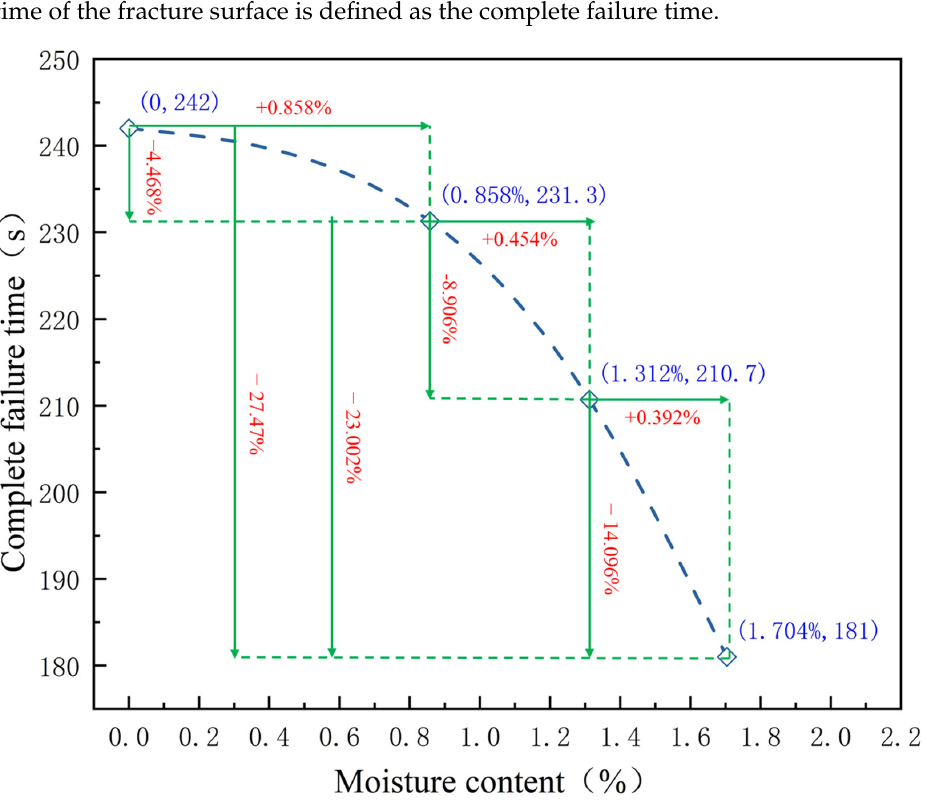
Figure 3. Relationship between water content of samples and complete failure time. The average water content of the natural samples was 0.858%, and their average com- plete destruction time under microwave radiation was 231.3 s. The average complete de- struction time of the dried samples was 242 s, which was about 4.468% higher than the average complete destruction time of samples with the natural state. The average water content of the water-soaked 24 h samples was 1.312%, and their average complete destruc- tion time under microwave radiation was reduced to 210.7 s, which was 8.91% lower than that of samples with the natural state. The average water content of the saturated samples was 1.704%, and the complete destruction time under microwave radiation plummeted